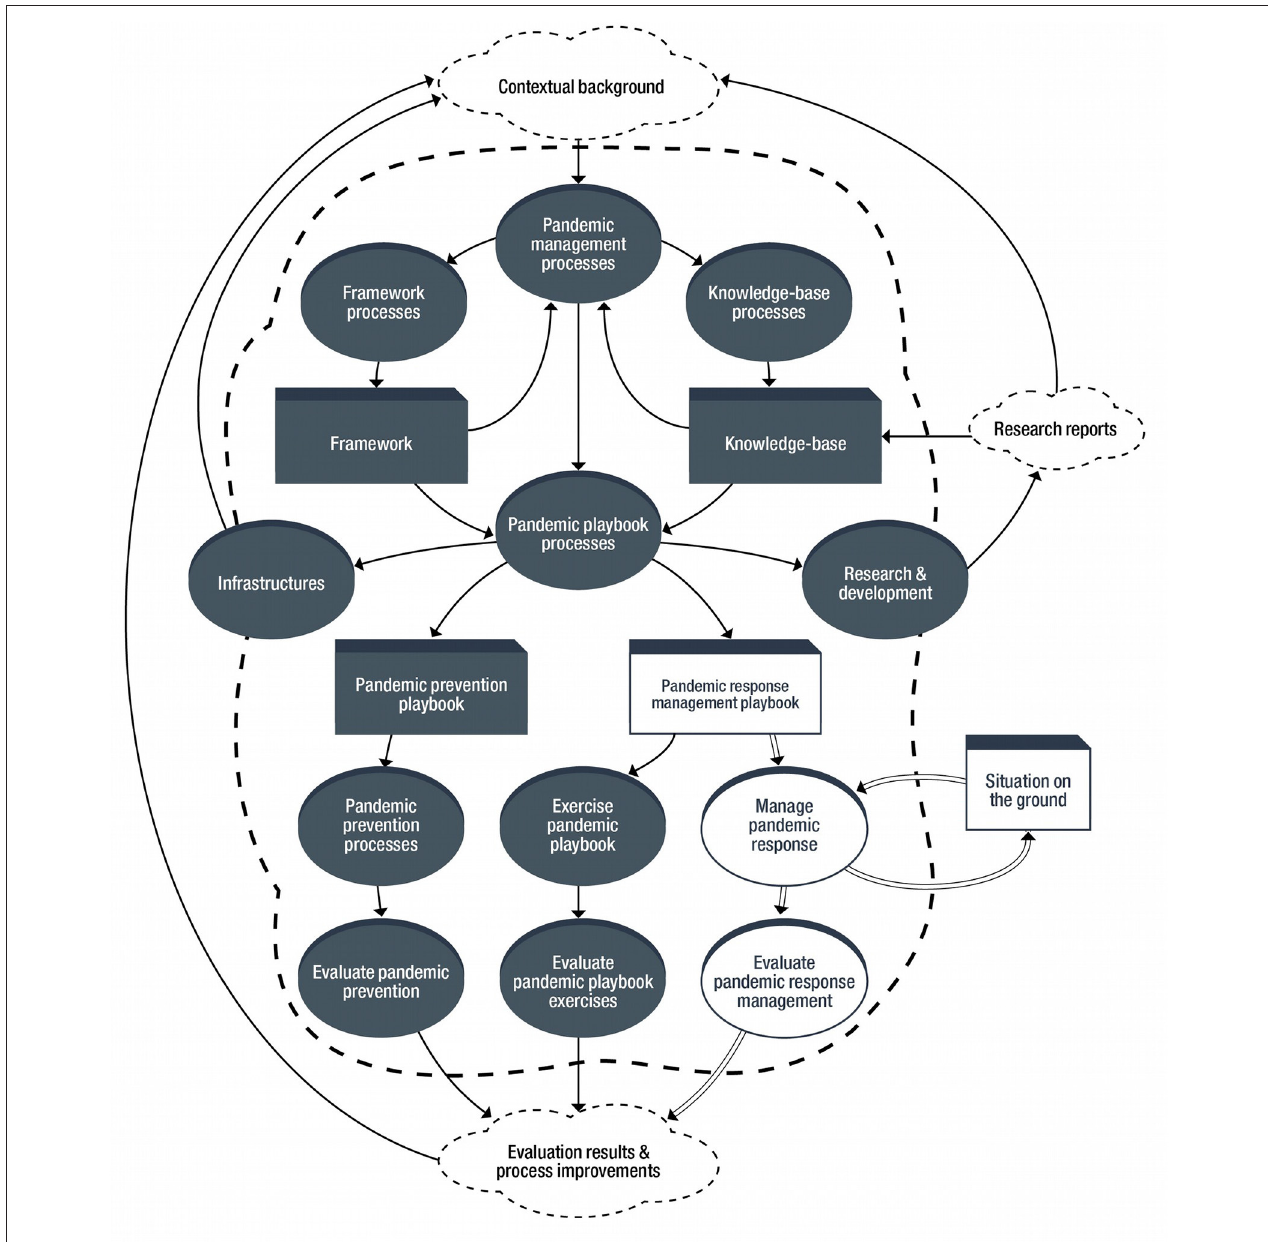
FIGURE 1 | Pandemic playbook